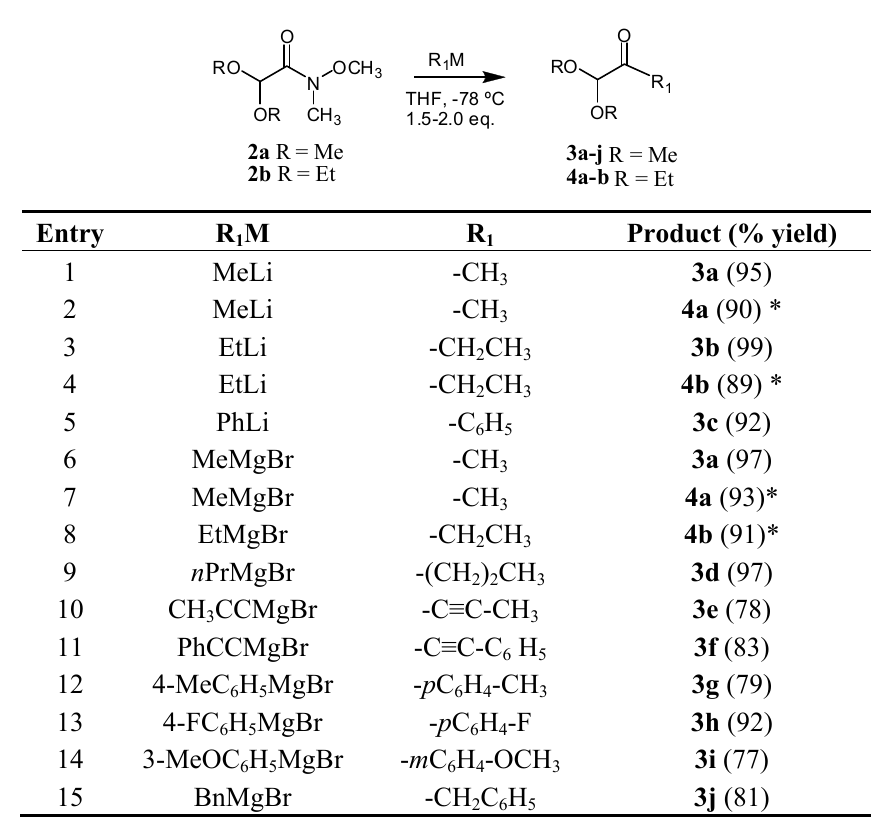
Table 1. Results of the addition of a representative number of nucleophiles to Weinreb amides 2a , b